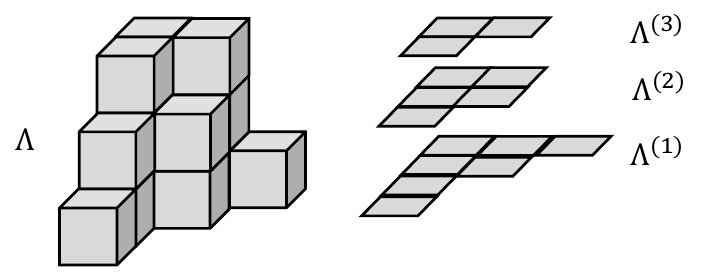
Figure 2. 3d Young diagram as a combination of 2d Young